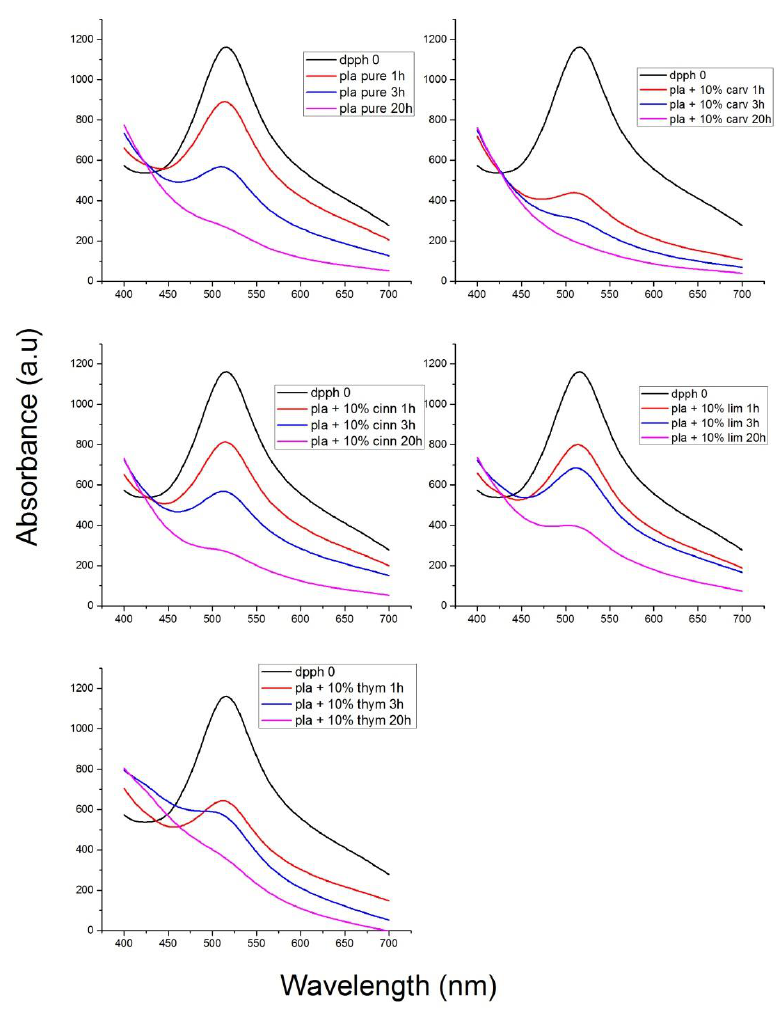
Figure 16. Effect of time stored in the DPPH solution of neat PLA and its composites with 10% of thymol carvacrol, limonene or cinnamaldehyde.